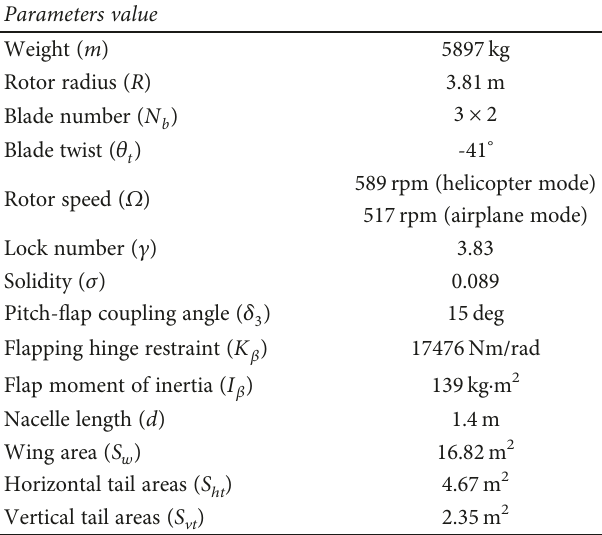
Table 1: Basic parameters of XV-15